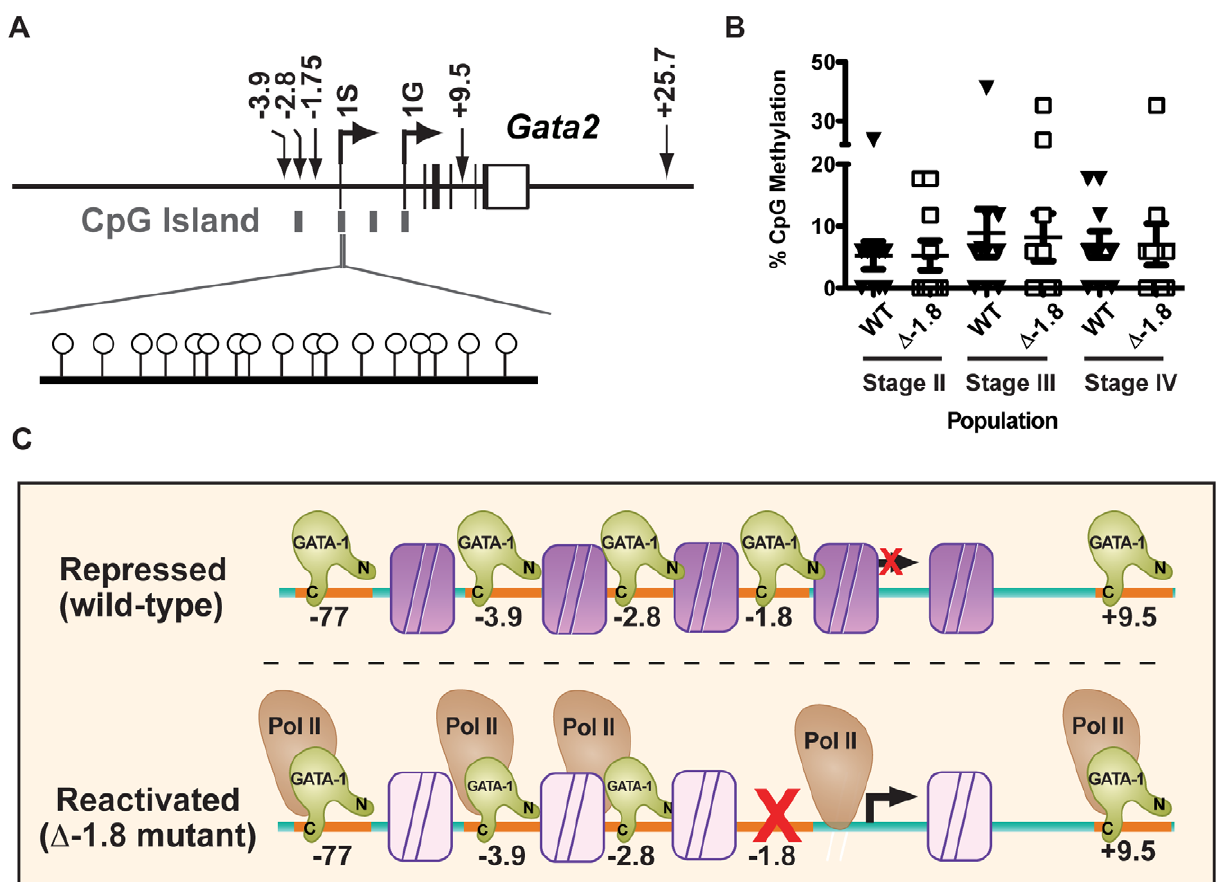
Figure 8. Gata2 promoter methylation does not require the 2 1.8 kb site. CpG island locations within the Gata2 locus (A). Percentage of CpG methylation within the 3 9 region of the 1S promoter in Stage II, III and IV erythroid cells from E14.5 wild-type and D -1.8 fetal liver (B). A model of the maintenance of Gata2 locus repression, mediated through maximal GATA-1 binding, repressive histone marks (purple), and complete Pol II expulsion. In the absence of the 2 1.8 kb site, GATA-1 binding is diminished, leading to a reduction in repressive histone marks (transparent) and allowing Pol II occupancy (C).